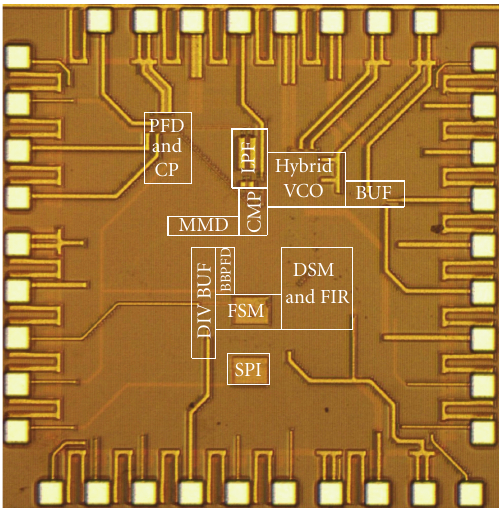
Figure 11: Chip micrograph